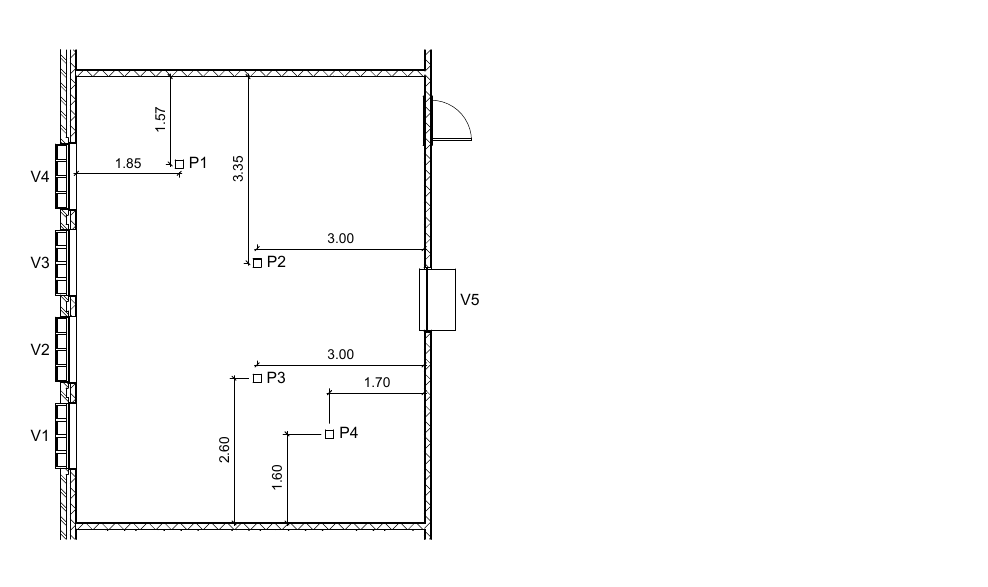
Figure 2. Floor plan of the classroom. The sensors positions P1 to P4 are identified and windows are labelled. Windows V1 to V4 connect to the outdoor playground and window V5 connects to an interior